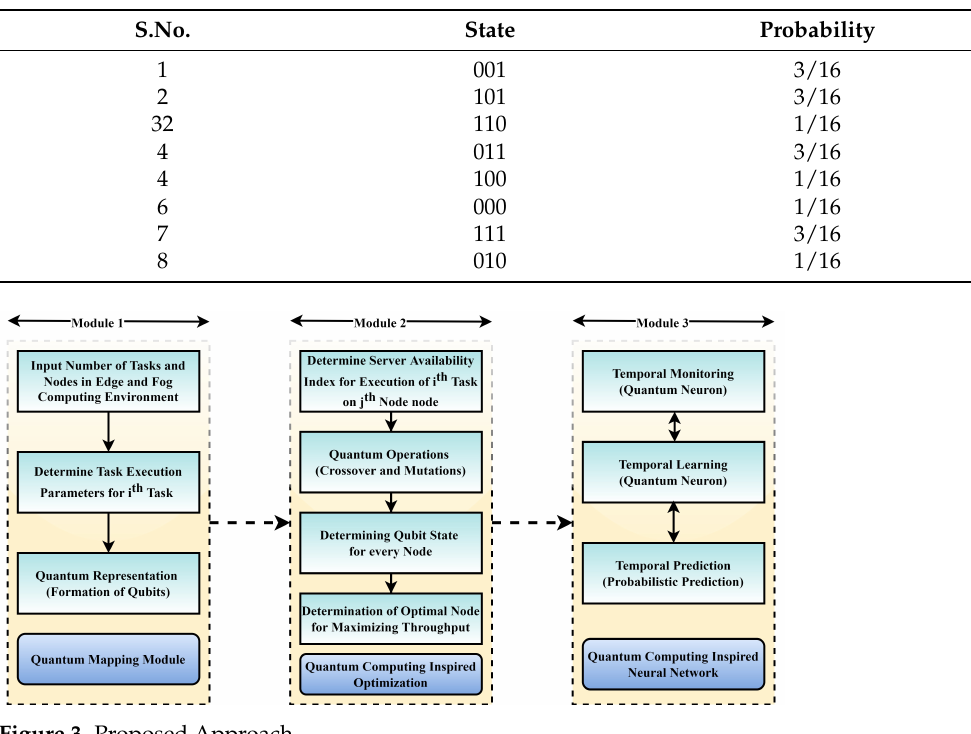
Table 1. Qubit State Probability.